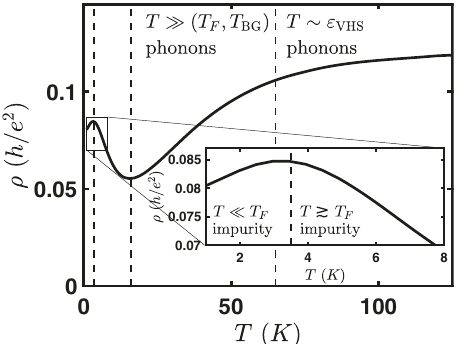
Fig. 1 Illustration of the different carrier transport regimes in twisted bilayer graphene. Electron – phonon scattering dominates except at very low temperature. At intermediate temperature ( T F , T BG ) ≪ T < T VHS , resistivity is linear-in- T and at high temperature ( T ∼ ε VHS ), resistivity saturates as a function of temperature. Inset: electron-impurity scattering dominates the transport at low temperature. Resistivity increases for T ≪ T F and decreases for T ≳ T F . This nonmonotonicity arises from the charged impurity scattering 40 , and when the system crosses over from the degenerate to the nondegenerate